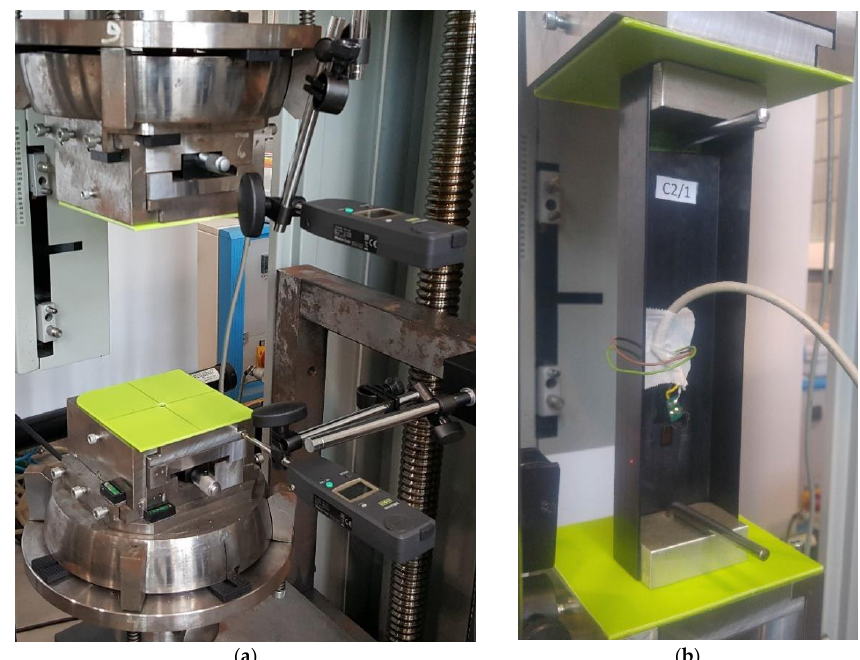
Figure 3. Experimental setup: ( a ) calibration of ball-and-socket joint head position, ( b ) position of a specimen on the sliding tables.